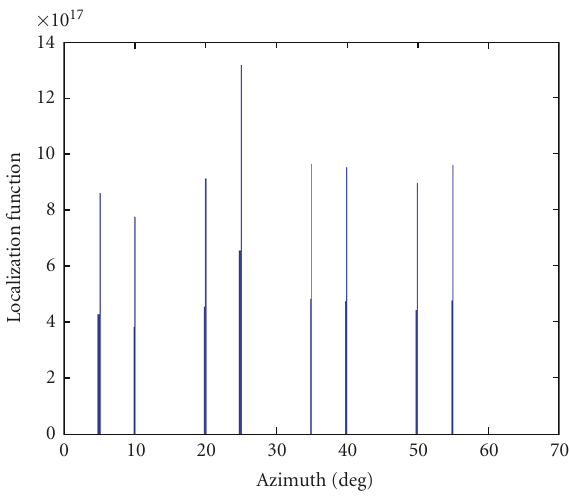
Figure 3: Π R -propagator with SNR = 0